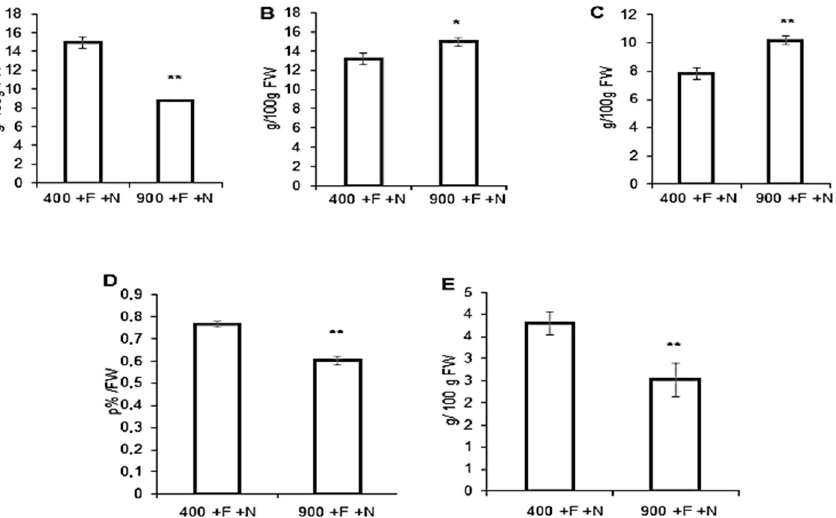
Figure 1. Macronutrient content of Micro-Tom tomato fruits. Fruits samples were collected from hydroponically grown plants (Control condition: +F/+N) under ambient (400) ppm or elevated (900 ppm) atmospheric CO 2 concentrations. ( A ) Sucrose, ( B ) Fructose, ( C ) Glucose, ( D ) Total proteins, ( E ) Total lipids. T -test significance: *, p < 0.05; **, p < 0.01.